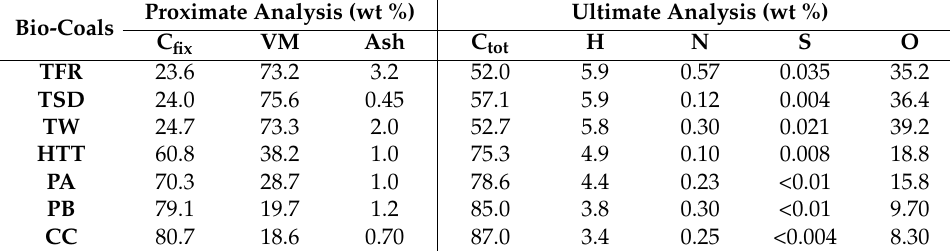
Table 2. Proximate and ultimate values of the used bio-coals materials (dry